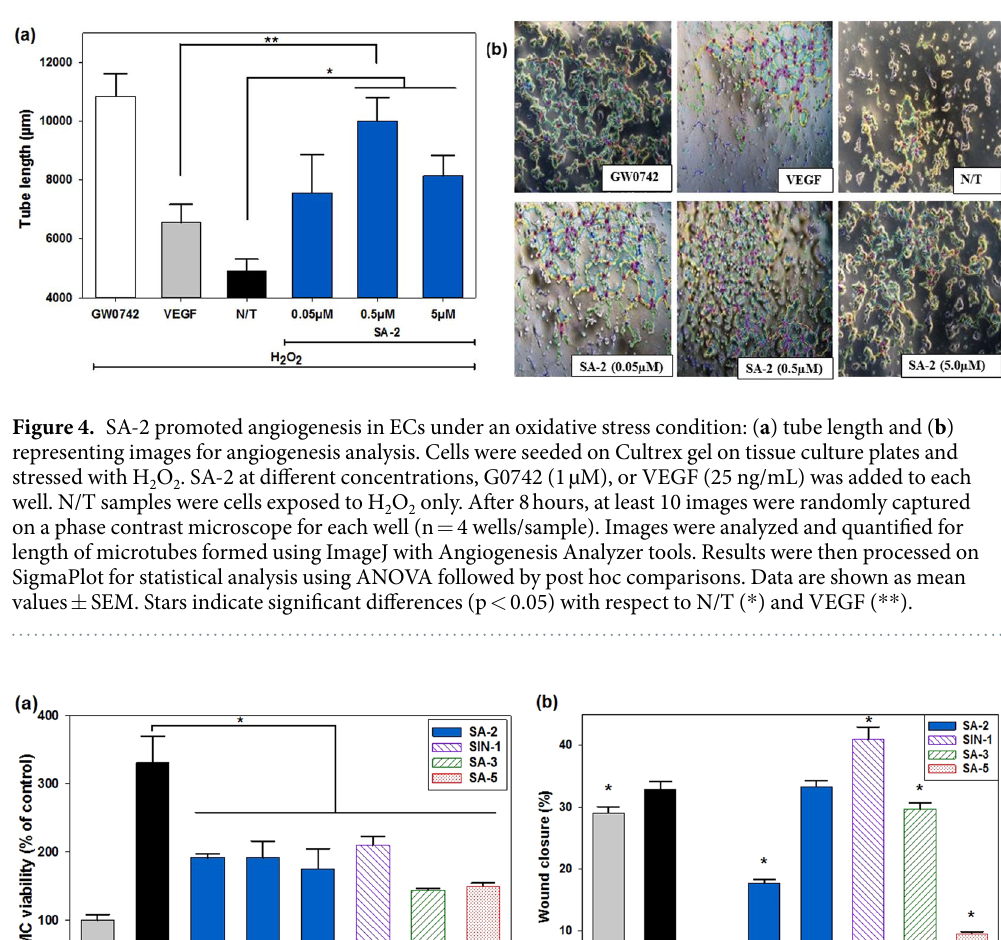
(Fig. 3a). As observed, cells treated with a low dose of SA-2 (0.05 μ M–0.5 μ M) migrated similarly to the control group (Fig. 3b), while SIN-1 showed the lowest cell migration. SA-3 and SA-5 showed an intermediate effect, but at a higher concentration (50 μ M). Effects of SA-2 on the formation of new blood vessels.